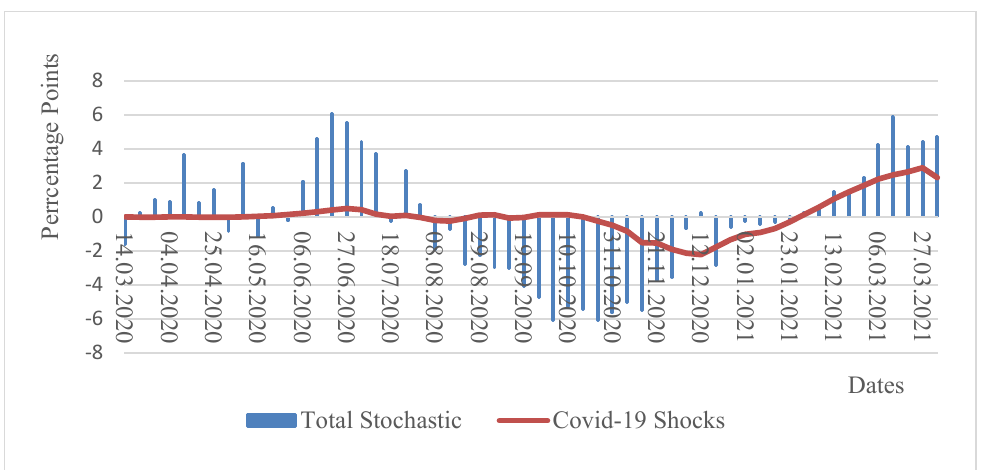
Fig. 6. Historical decomposition of the unemployment